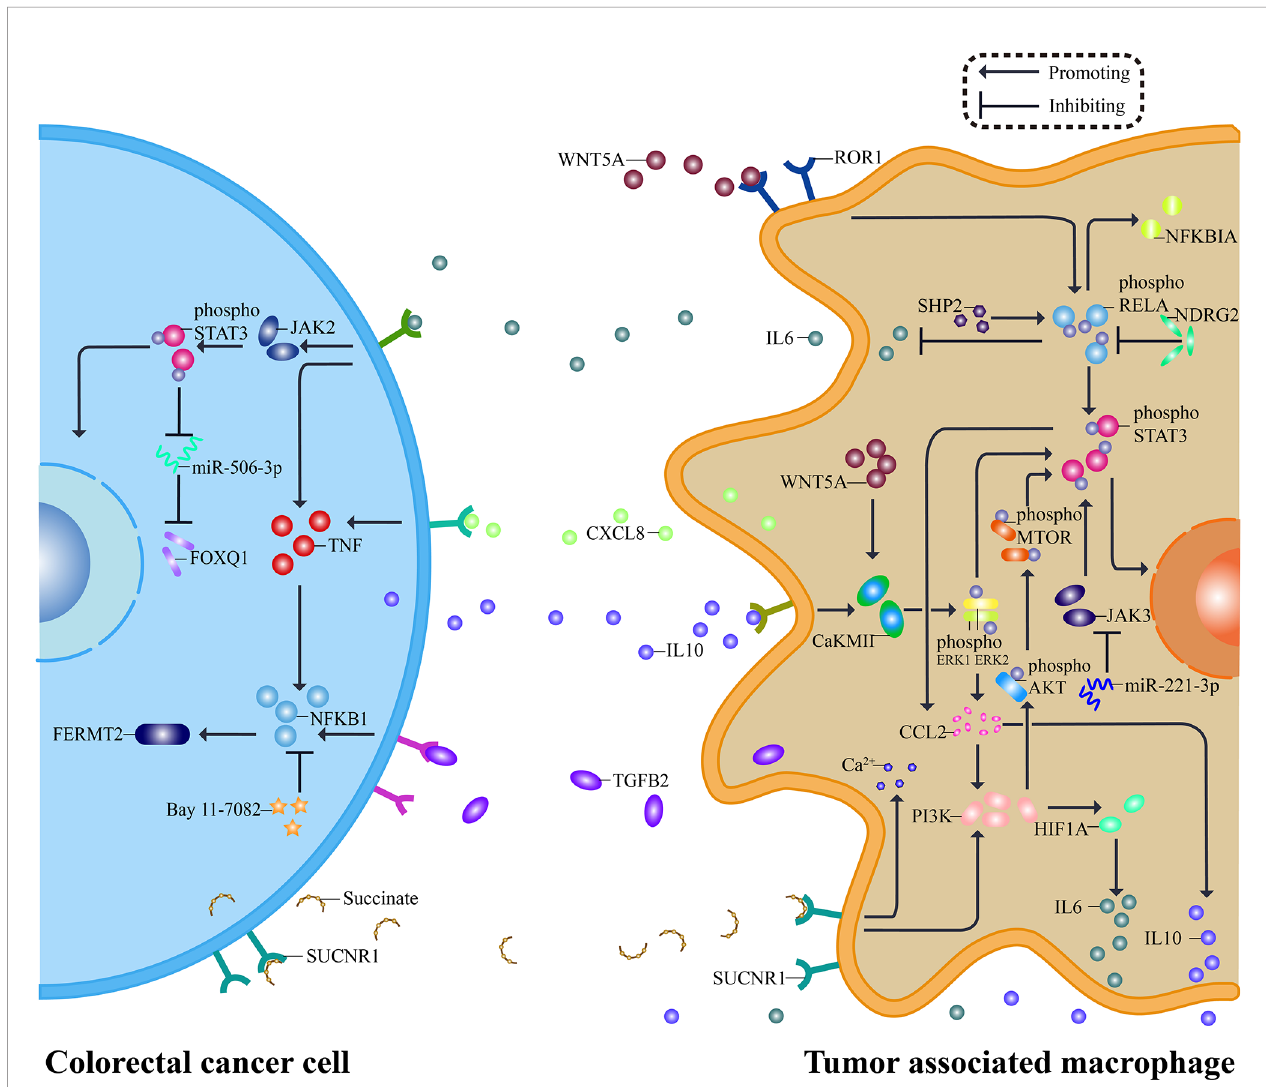
FIGURE 2 | Pathways between TAMs and CRC. The interaction between CRC and TAMs relies on a complex molecular network. Tumor cells release molecules such as IL10 and Succinate, activating STAT3 pathway and PI3K pathway in macrophages. Consequently, pro-tumor cytokines, including IL6, CXCL8, and TGFB2, are secreted out of TAMs and targeted to their receptor on the surface of CRC cells. Speci fi c inhibitors aiming at essential pathway points effectively reverse the pro- tumor process, typically miR-221-3P inhibiting STAT3 pathway by silencing JAK3. Besides, WNT5A and NFKB1 contribute to the network, and each pathway is not independent but interconnected. The secreted pro-tumor cytokines cause the response of JAK2, TNF, and NFKB1, serving CRC. A similar network can be seen both in TAMs and CRC, and suppressors inside it may have a dual